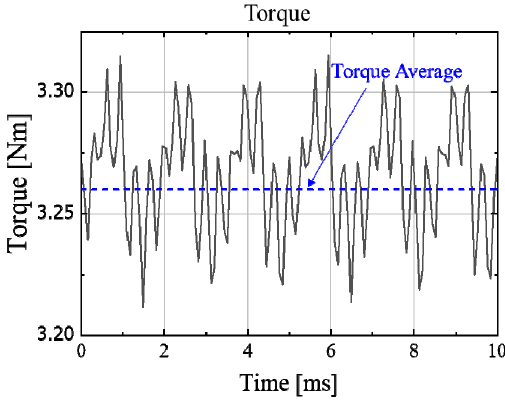
Figure 2. Torque output of IPMSM .